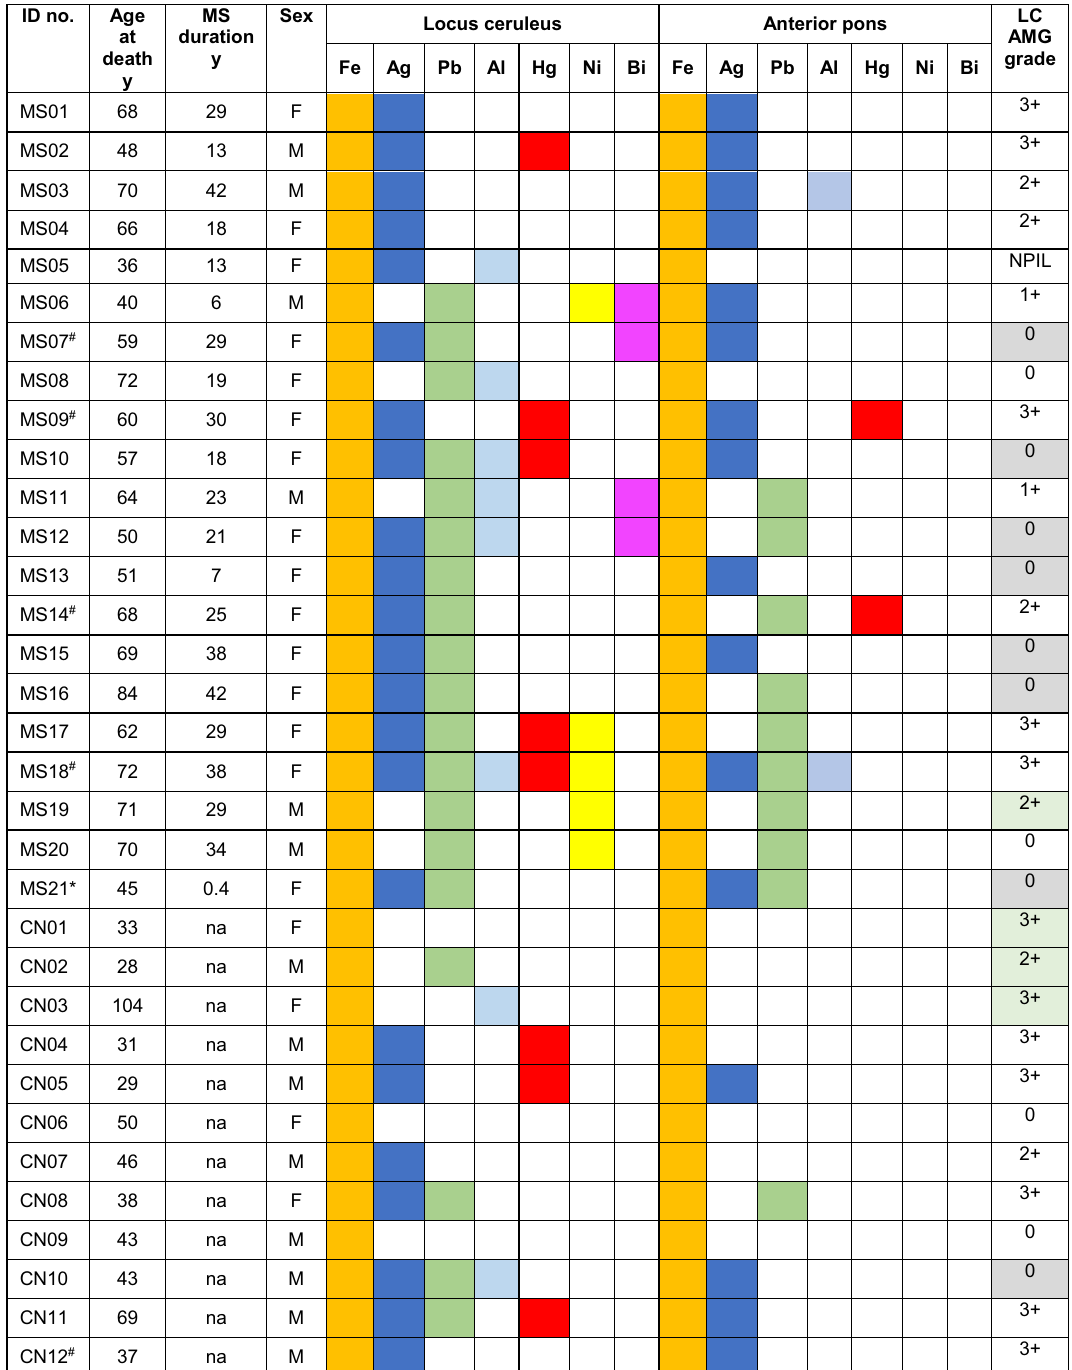
Table 1. Potentially toxic elements detected on LA-ICP-MSI in the locus ceruleus and anterior pons. In the column on the right, grey shading indicates samples that are AMG negative but LA-ICP-MSI positive for Ag, Hg, or Bi; green shading indicates samples that are AMG positive but LA-ICP-MSI negative for Ag, Hg and Bi. LC locus ceruleus, AMG autometallography, CN control, MS multiple sclerosis, NPIL neuropil, na not applicable. *Subacute MS (others chronic). # Widespread AMG-detected